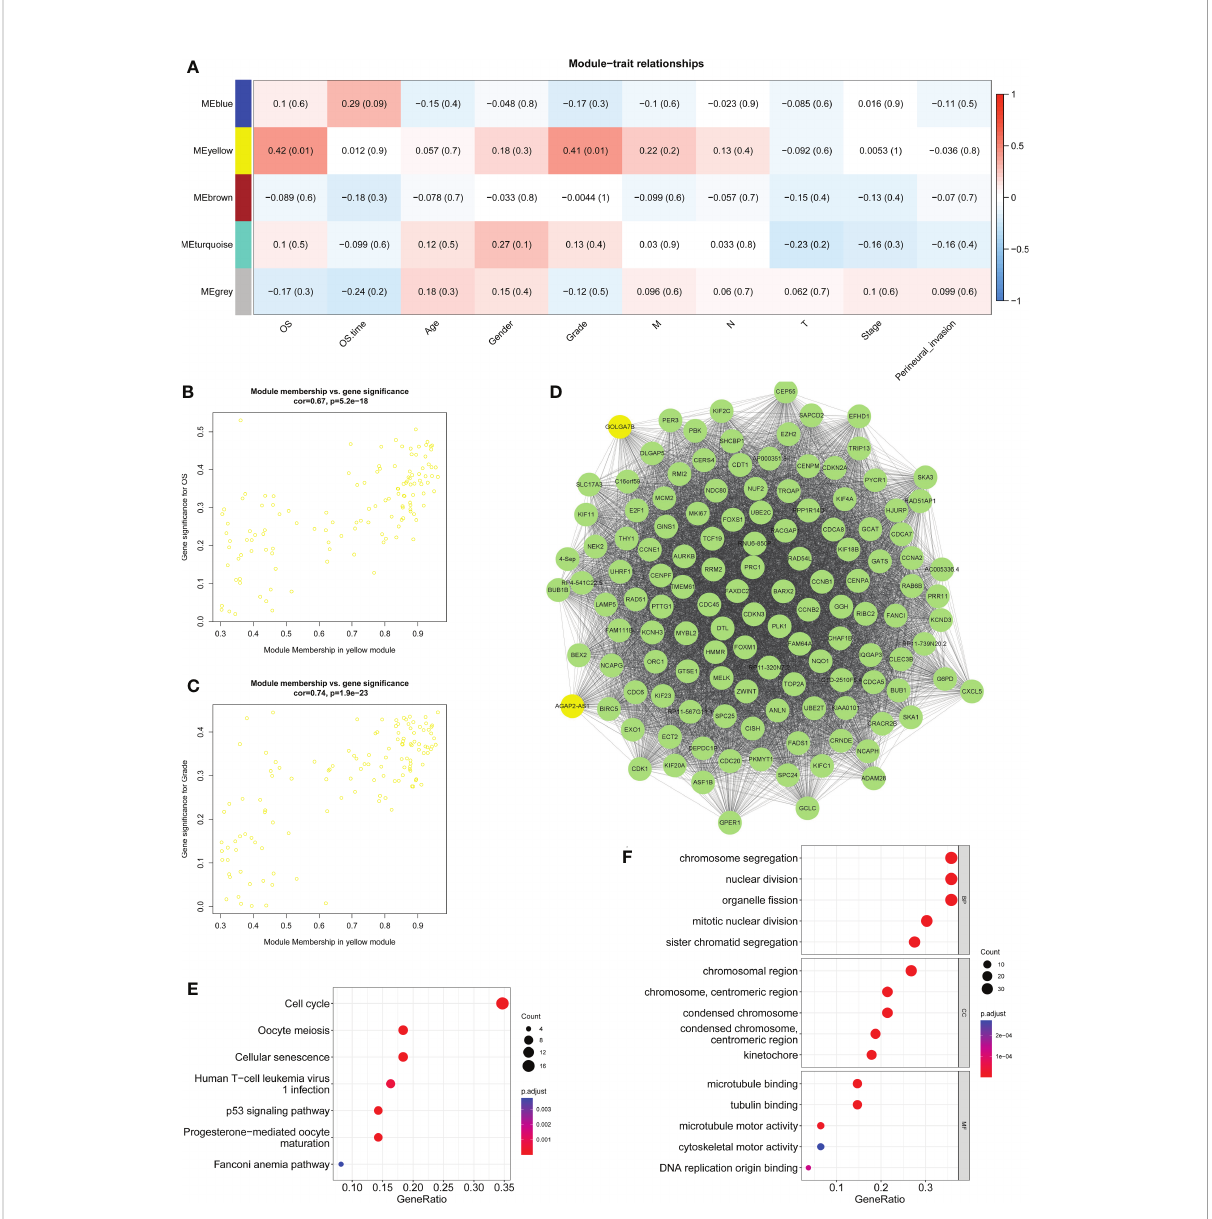
FIGURE 2 Determination of key modules related to clinical features. (A) Heatmap displaying the correlation between the coexpression modules and clinical traits and highlighting the yellow module as signi fi cantly related to survival and histologic neoplasm grade. (B) Scatter plot showing the correlation between gene signi fi cance and survival in the yellow module. (C) Scatter plot showing the correction between the gene signi fi cance and histologic neoplasm grade in the yellow module. (D) Gene interaction network of the 128 genes in the yellow module. (E) KEGG pathway enrichment results for genes from the yellow module. (F) GO-BP, GO-CC and GO-MF enrichment analyses of genes from the yellow module. BP, biological process; CC, cellular component; MF, molecular